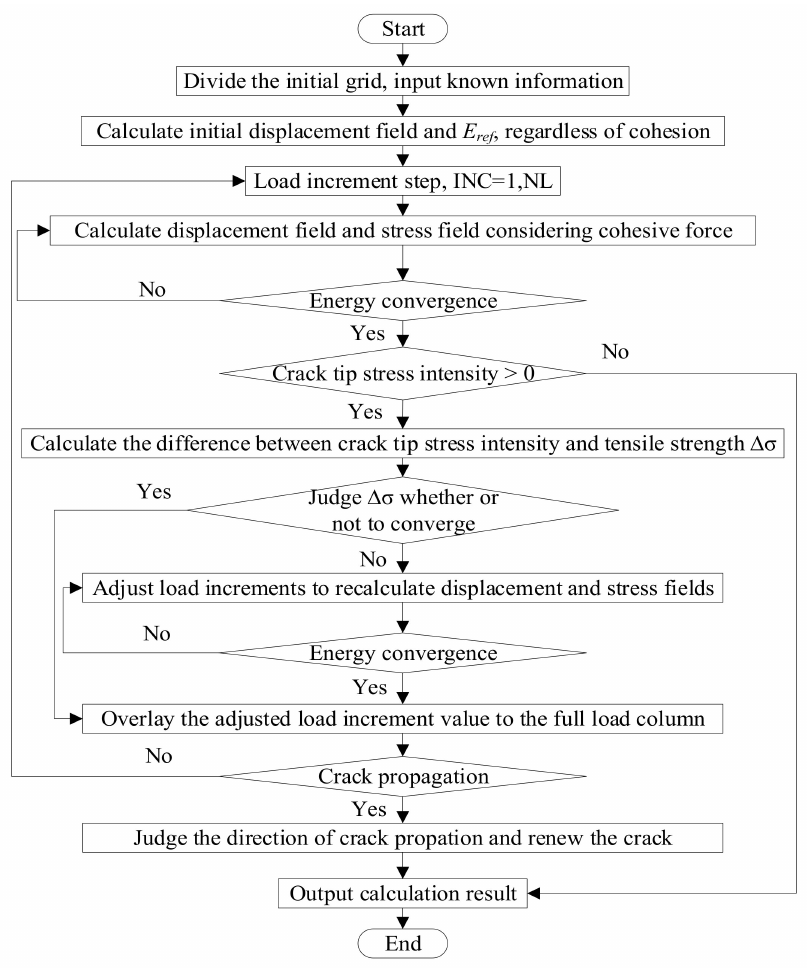
Figure 6. The incremental iterative propagation process of cohesive